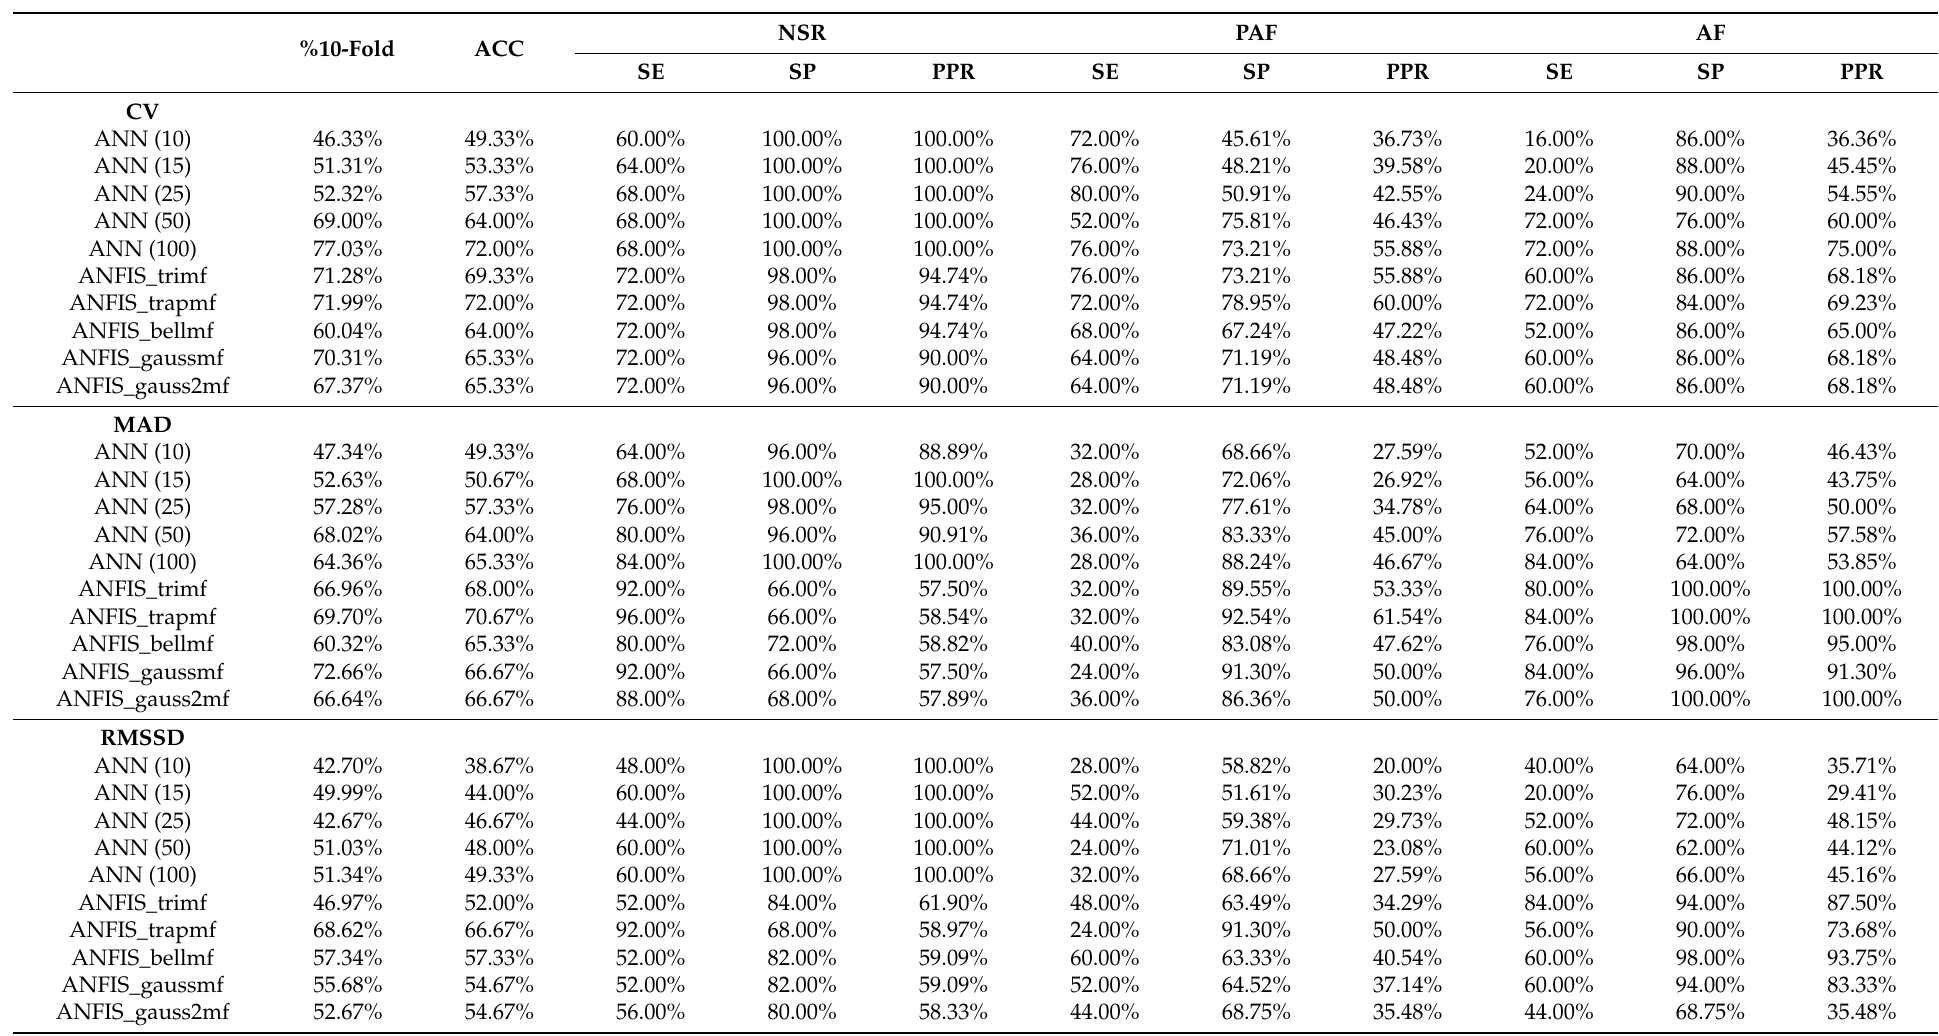
Table 2. Summary fitting and test